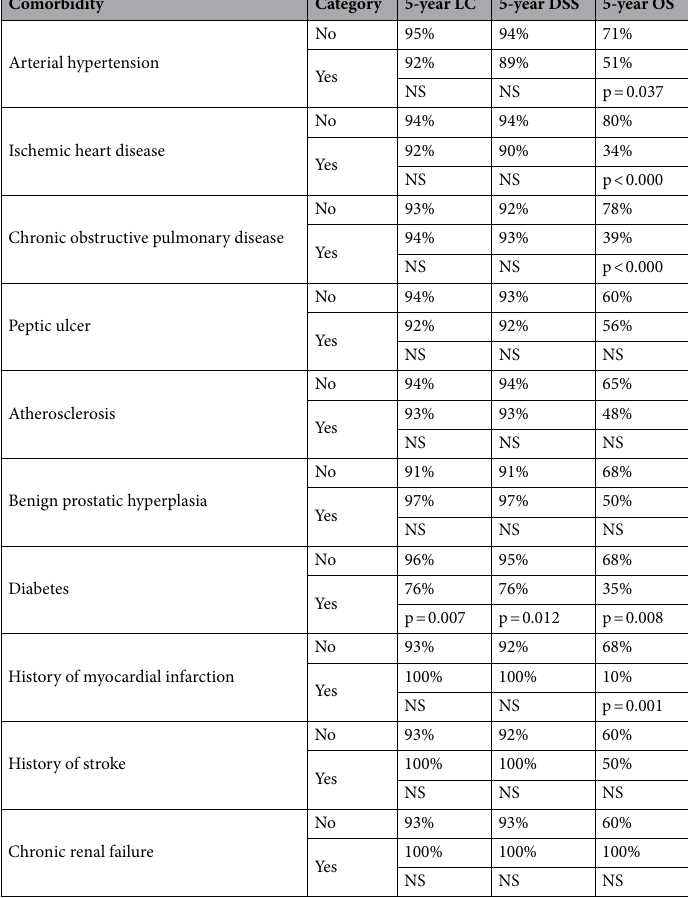
Table 3. The results of univariate analysis of correlations between comorbidities in relation to 5-year local control (LC), disease-specific survival (DSS), and overall survival (OS).